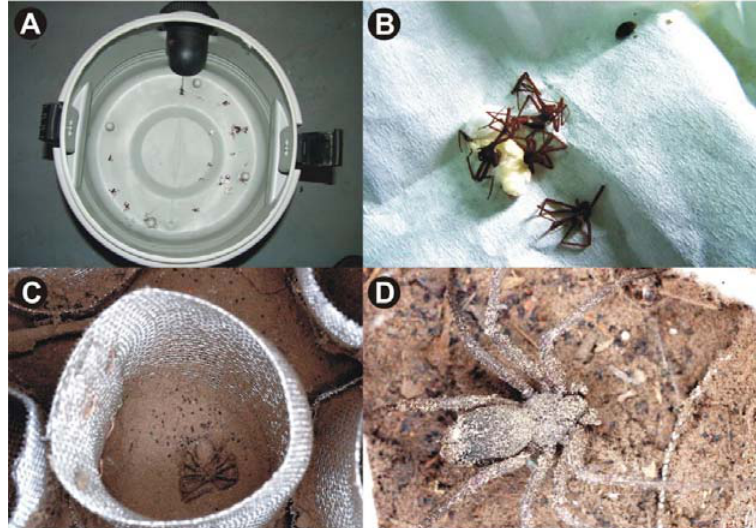
Figure 1. (A) Top view of the vacuum cleaner containing vacuumed Loxosceles intermedia . Note the plastic plate at the top of the photograph. (B) Vacuumed L. intermedia inside an open vacuum bag. (C) Dead young L. intermedia in the retention mesh inside the vacuum bag containing debris. (D) Female L. intermedia , at the end of Stage 8, inside the vacuum bag with